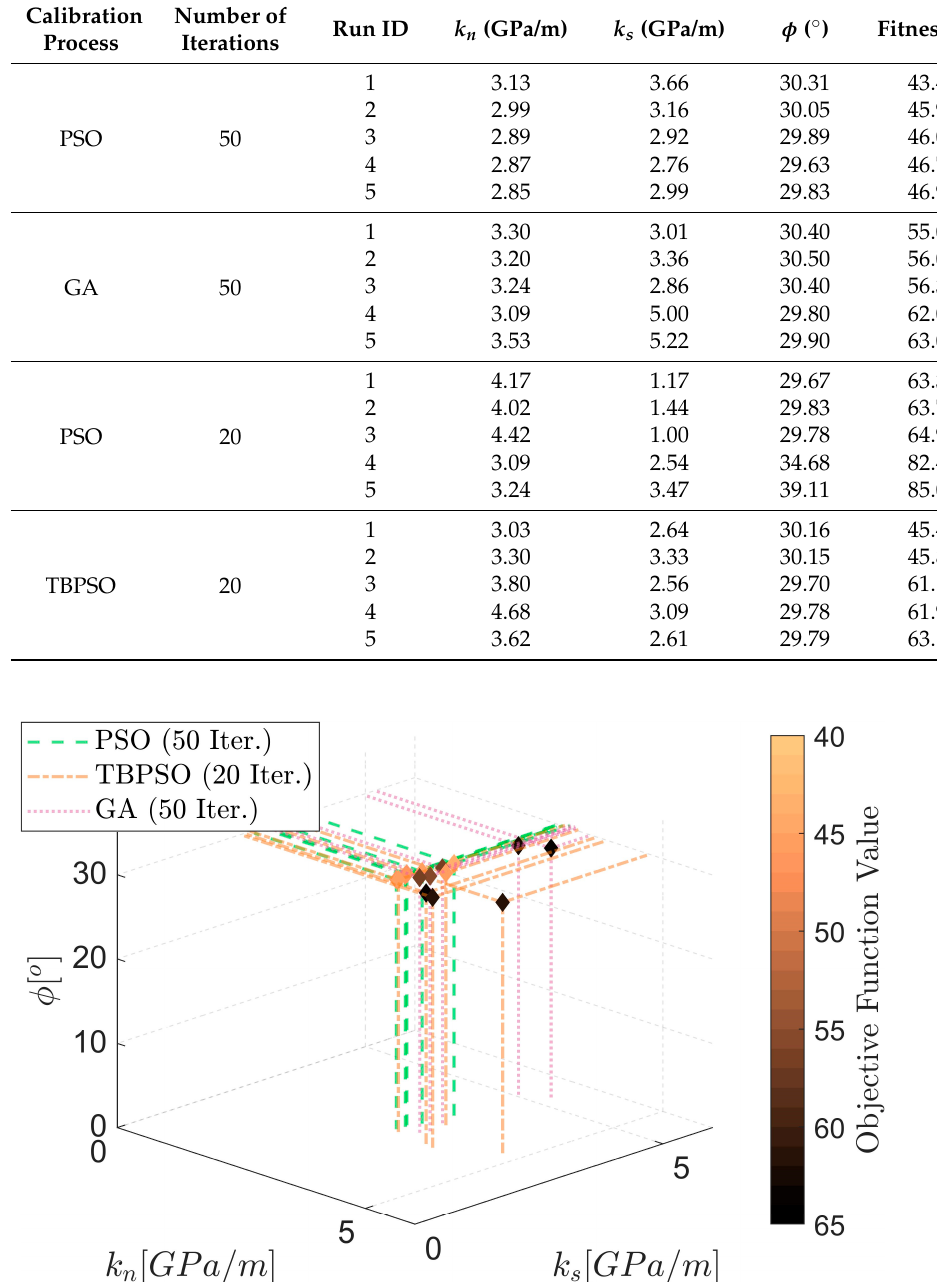
Table 1. Five best solution sets for objective function 1 of Pulatsu’s geometry.